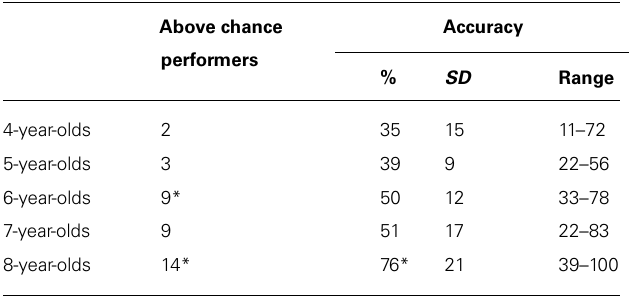
Table 1 | Number of children who performed above chance on the individual level, and mean accuracy (percentage, standard deviation, and range) per age